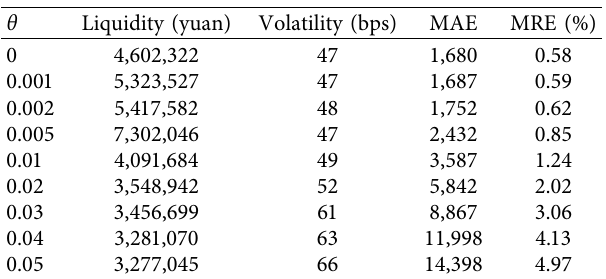
Table 7: The impact of speculator sentiment on the quality of the stock index futures market.